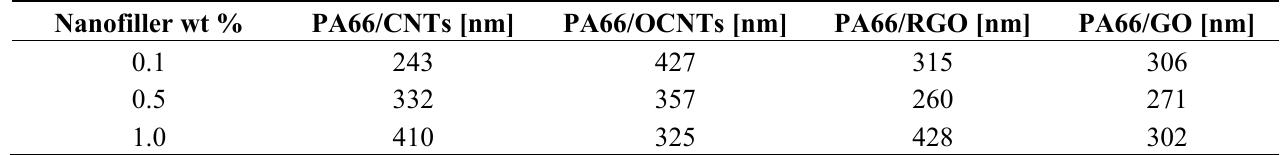
Table 3. Average diameters of the electrospun